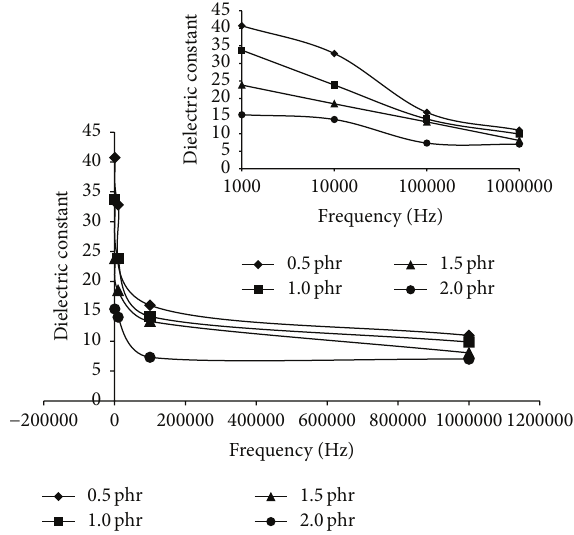
Figure 7: The value of dielectric constant of porous epoxy for epoxy, hardener, and latex (EHL) mixing by ultrasonic technique.